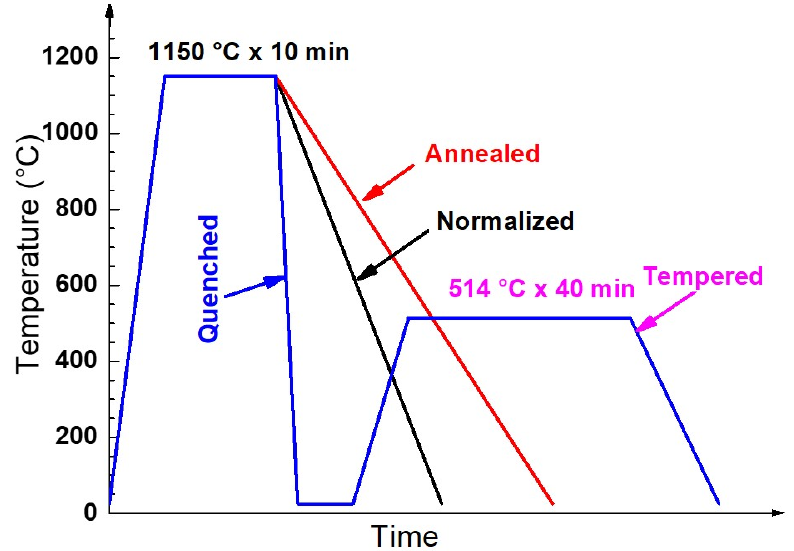
Figure 1. Schematic representation of the heat treatment schedules of 690 MPa grade steel used in the present work.